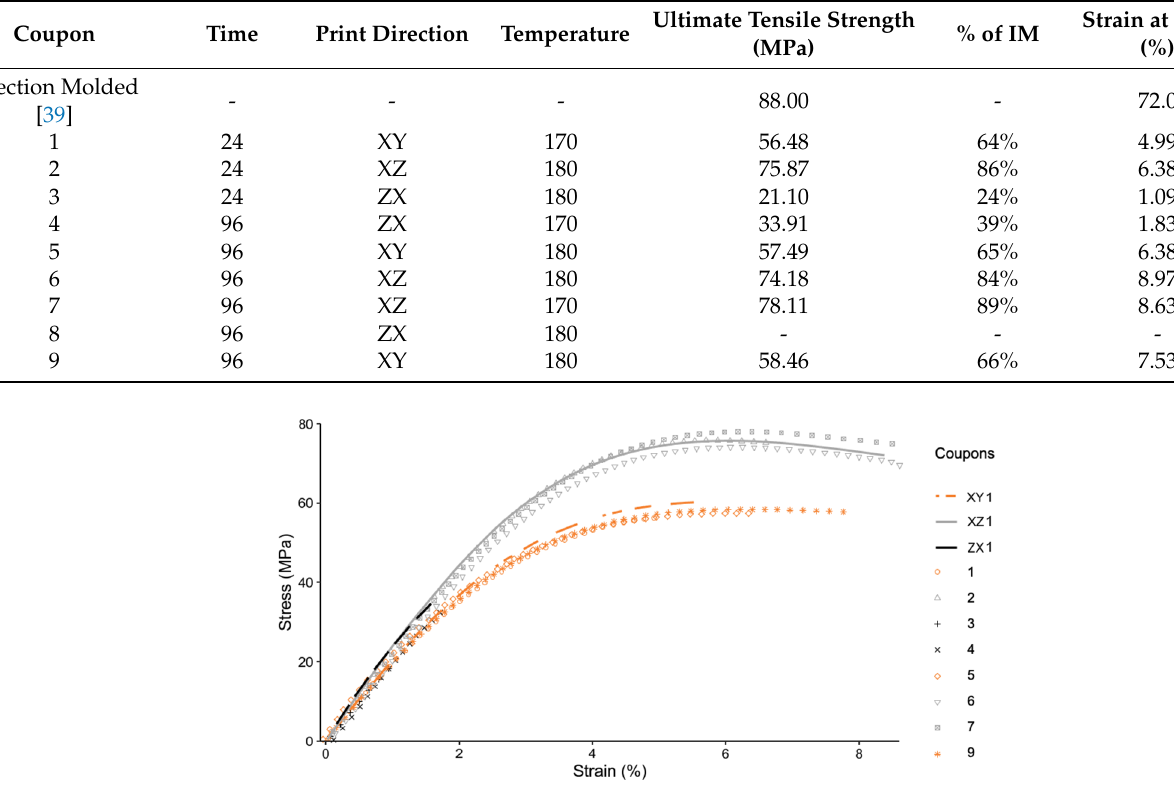
Figure 9. Stress–Strain curve for coupons printed in XZ, annealed (2,6,7), and controls (XZ1). Figure 8 compares annealed coupons and the representative control coupon printed in the XY direction. From Figure 8, it is evident that the annealed coupons reach the plat- eau indicating plastic deformation sooner, while exhibiting higher strain at break and duc- tility as compared to the unannealed samples. However, higher ductility is traded off for a slight decrease in tensile strength, as compared to the control. Coupon 1 is an anomaly, as both strength and strain at break fall short of the unannealed sample. Figure 9 compares annealed coupons and the representative control coupon printed in the XZ direction. From Figure 9, it is evident that the annealed coupons tend to have closer spread for both the tensile strength and the elongation at break of the coupons. The highest tensile strength was achieved by the thermally annealed coupon, reaching a strength up to 89% of the IM specimen. To identify the significance of the effect on annealing on both ultimate tensile strength and strain at break, the effects plot is plotted as shown in Figure 10a,b, respec- tively. In both cases, the variation in tensile properties due to the change in print direction is much more significant than the effect of annealing in this experiment. This means that the annealing did not achieve a significant reduction in anisotropy resulting from the dif- ferent print direction. Nonetheless, it is observed that longer and higher annealing tem- perature improved mechanical properties.